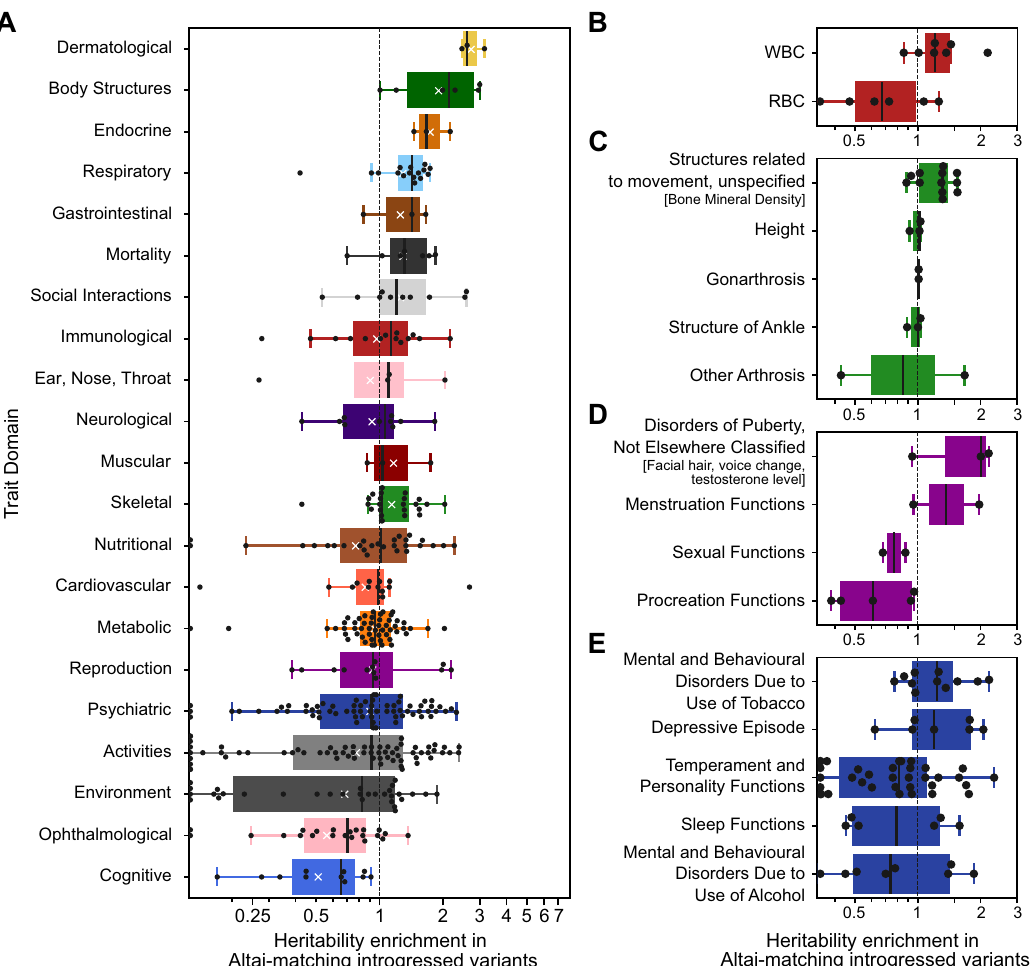
Fig. 2 Heritability enrichment and depletion in introgressed variants across 405 traits clustered by domain. A Altai-matching introgressed variants are most enriched for dermatological traits (hair-related) and most depleted for cognitive traits (higher-level cognitive and memory functions). Each point represents heritability enrichment or depletion of one trait among Altai-matching introgressed variants. Traits with depletion less than 0.125 are plotted on the baseline for visualization. Within some domains, introgressed variants also show variable heritability enrichment. B Dividing immunologic traits into subchapters, Altai-matching introgressed variants contribute more to the heritability of WBC-related traits (1.3-fold enriched, n = 7) and less to RBC- related traits (1.5-fold depleted, n = 6) ( P = 0.02, two-tailed two-sample t -test). C For skeletal traits, bone mineral density-related traits show the most enrichment for heritability in introgressed variants (1.2-fold enriched, q = 0.01, n = 12). D For reproductive traits, puberty- and menstruation-related traits are enriched for heritability (1.5-fold enriched, q = 0.1, n = 5), whereas sexual and procreation functions are depleted (1.5-fold depleted, q = 0.05, n = 7). E For psychiatric traits, tobacco use disorders trend towards enrichment (1.2-fold enriched, q = 0.23, n = 11), consistent with previous observations, while introgressed variants are depleted for contribution to personality-related functions (1.4-fold depleted, q = 0.07, n = 35). Unless otherwise speci fi ed, all q values are from two-tailed one-sample t -tests with Benjamini – Hochberg FDR correction at the 0.05 level. The domain, chapter, and subchapter-level results across all traits are similar when considering other sets of introgressed variants (Figs. S10-S12, Table S2, Supplementary Data 3 – 4). The boxplot centers represent medians, the white Xs denote means, the boxes are bounded by the fi rst and third quartile, and the Tukey-style whiskers extend to a maximum of 1.5 × IQR beyond the